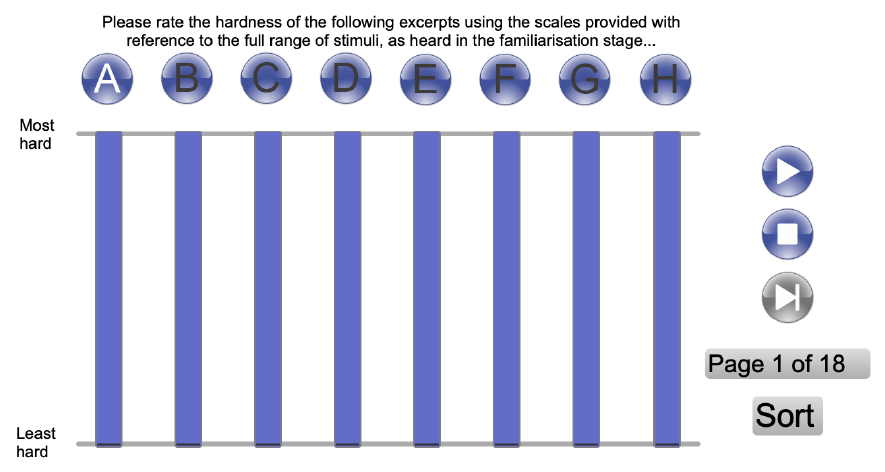
Figure 2. The listening test interface.